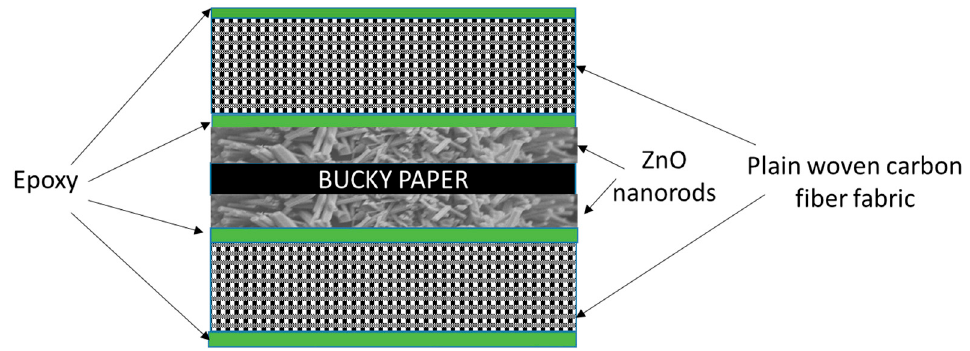
Figure 3. Schematic of the architecture of hand layup of a composite comprising carbon fibers and Bucky paper with surface grown ZnO nanorods